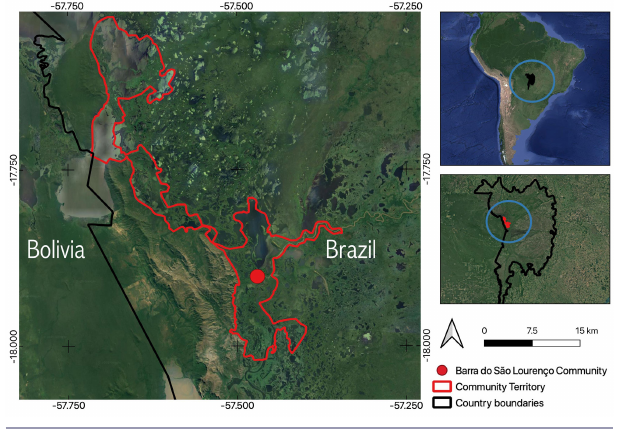
Fig. 1 . The location of Barra do São Lourenço community with the boundaries of their